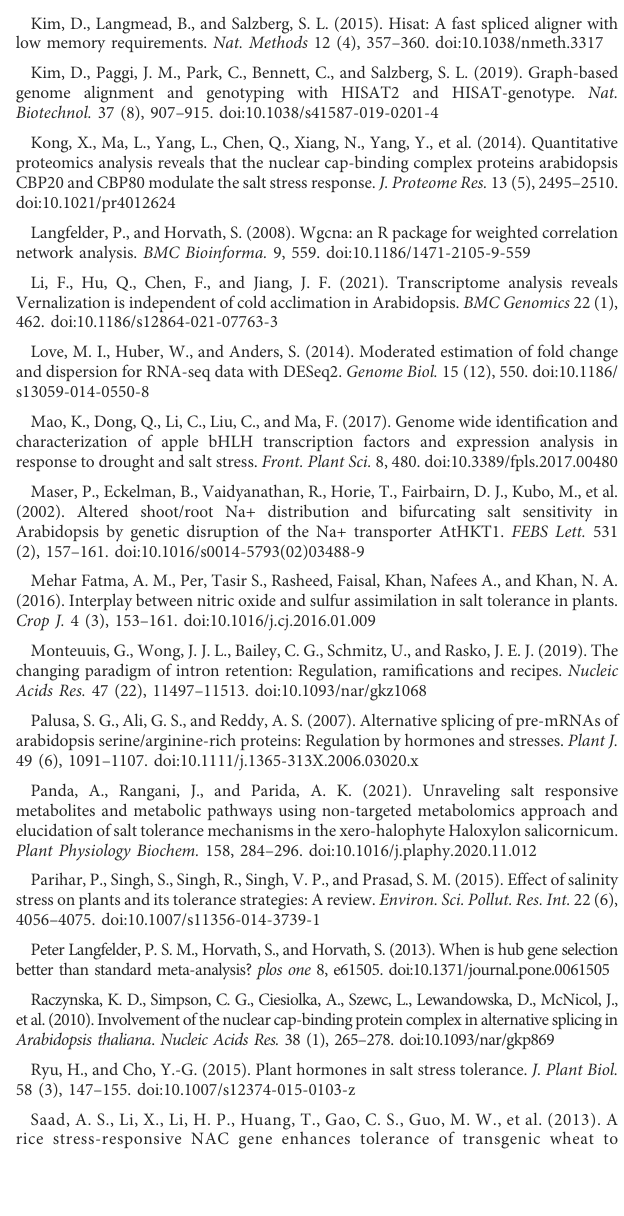
SUPPLEMENTARY FIGURE S1 Enriched KEGG analysis of 3,855 DEGs between salt-sensitive and salt- tolerant wheat root tissues at 0 h. SUPPLEMENTARY FIGURE S2 KEGG pathway for genes enriched in phenylpropanoid biosynthesis (ko00940)betweensalt-sensitiveandsalt-tolerantwheatroottissuesat6 h. SUPPLEMENTARY FIGURE S3 Salttolerance-relatedtranscriptionfactorsinDEGs6 haftersaltstressinroot tissue. SUPPLEMENTARY FIGURE S4 In total, 1,639 DEGs were present in leaf tissue at all three time points (0, 6, and 24 h). SUPPLEMENTARY FIGURE S5 Correlations between RNA-Seq and qRT-PCR results. SUPPLEMENTARY FIGURE S6 Work fl ow of the salt-stressed experiment for the wheat strain